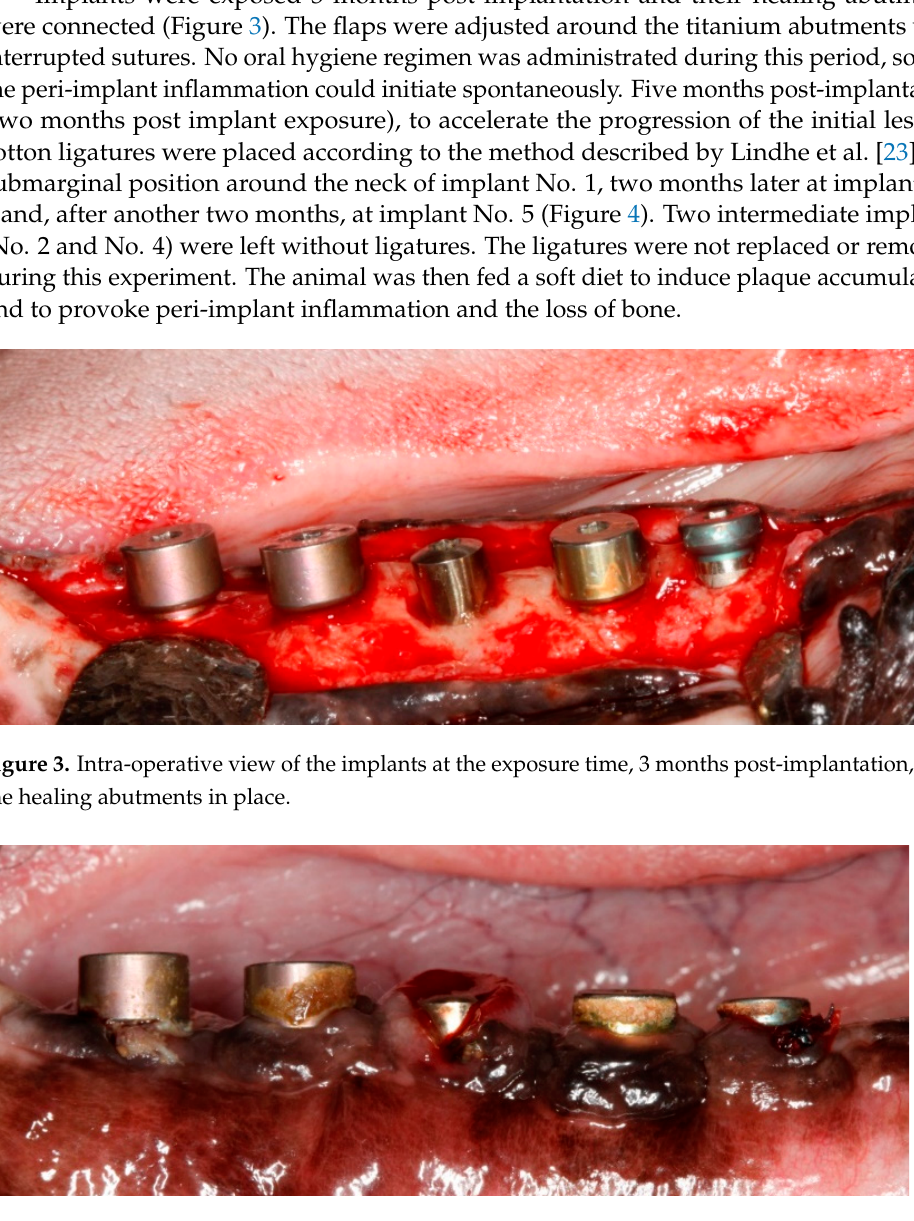
Figure 2. Intra-surgical image after the insertion of the implants. Note the integrity of the buccal bone, as a consequence of the rigorous prosthetic-driven implant placement.